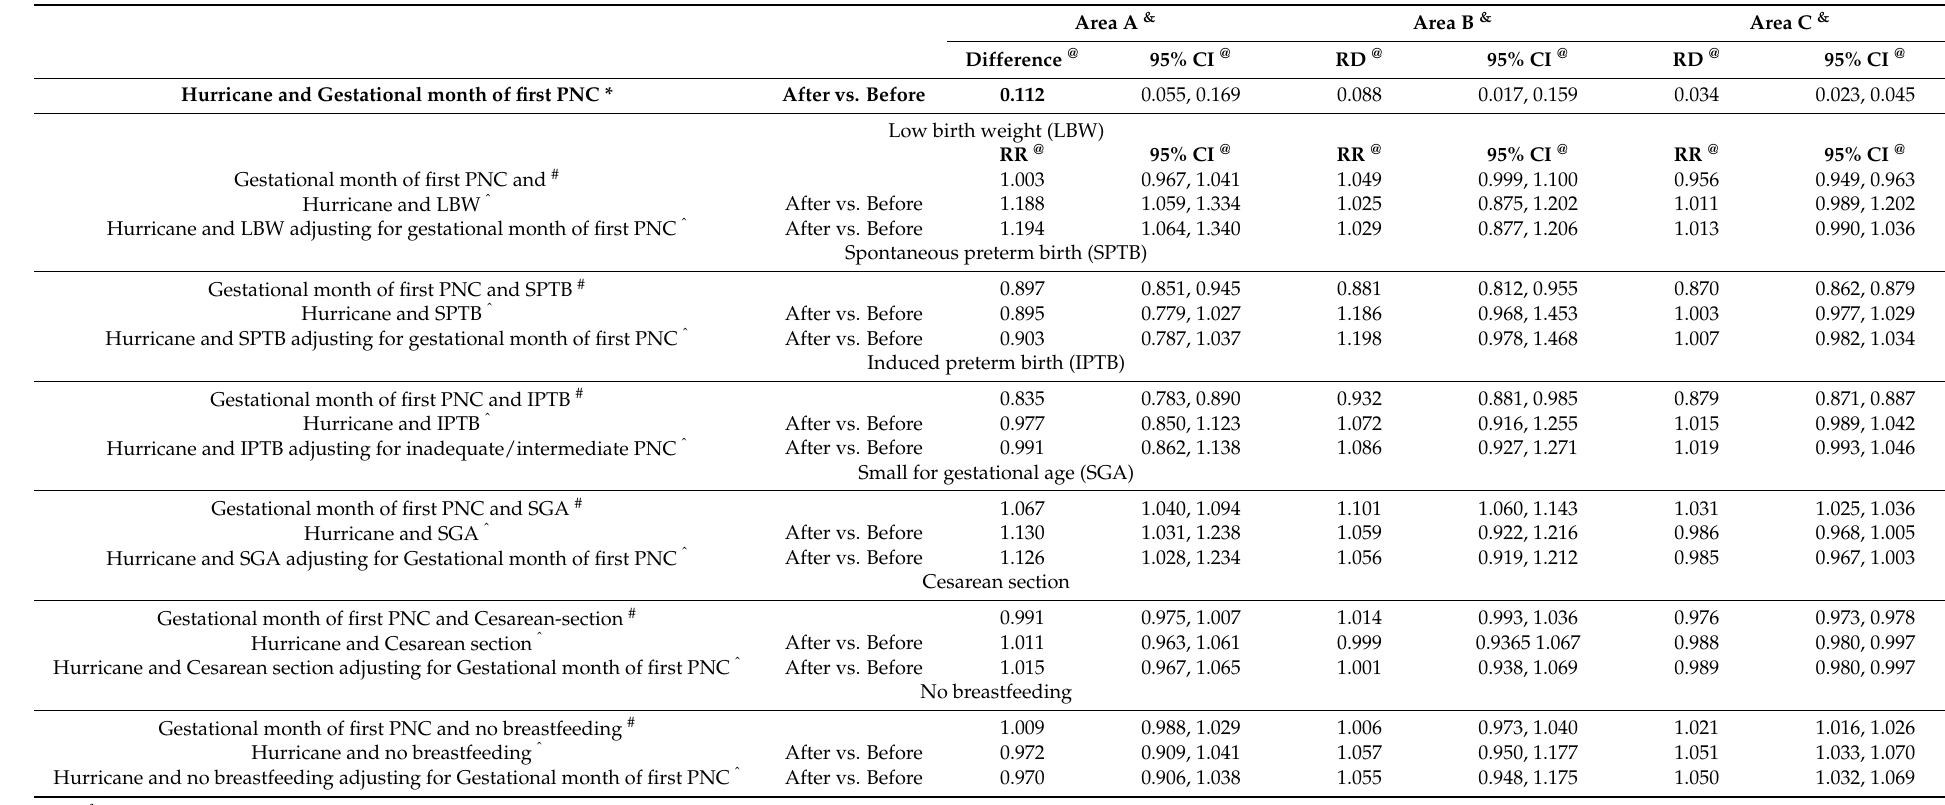
Table 5. The effect of PNC on the association between Hurricane Michael and perinatal outcomes in different areas. Area A & Area B & Area C